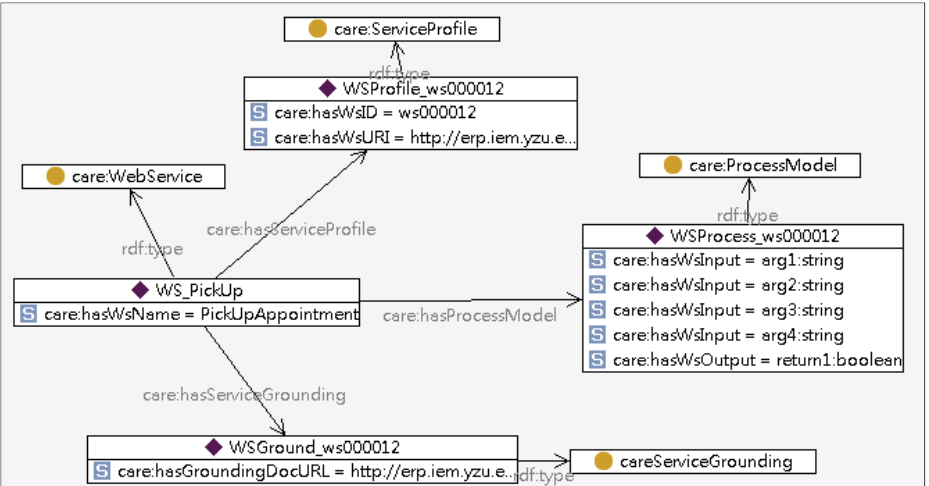
Figure 13. Partial ontology model of “Pick-up Web